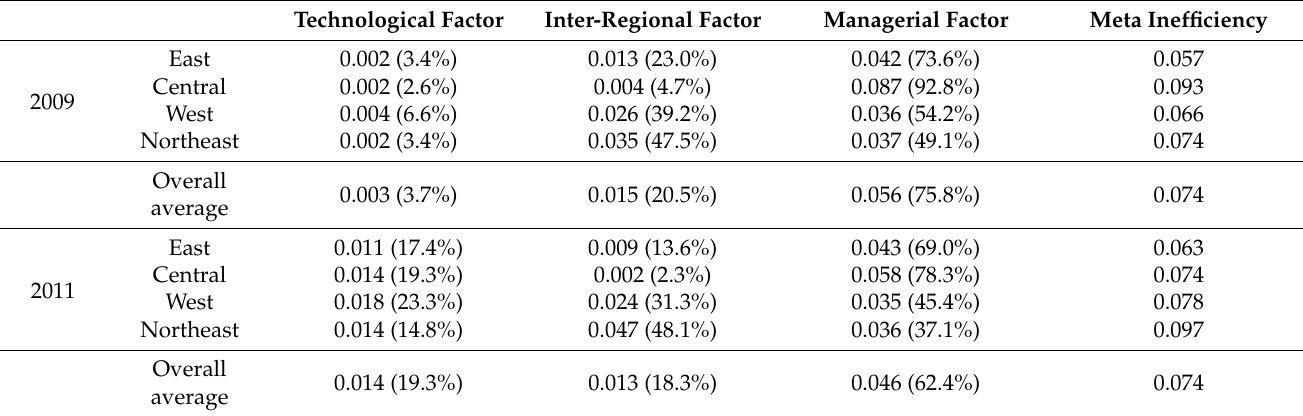
Table 2. Summary of the changes for each inefficiency factor and its components in the SM group. The percentage in parentheses represents the proportion of each factor to meta inefficiency.